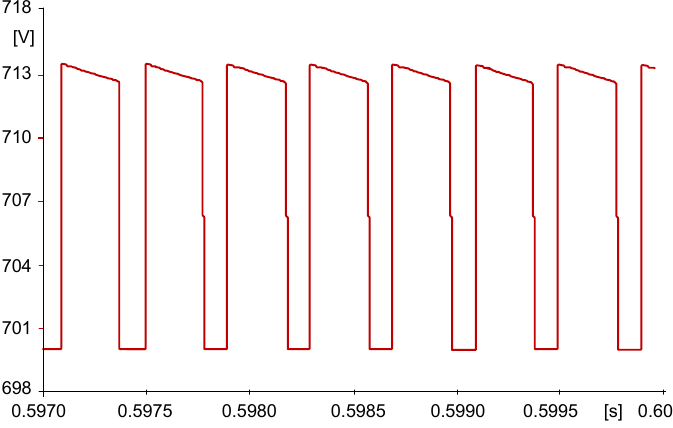
Figure 5. Variation of DC voltage for a cable with a length of 2 km, in proximity of the steady-state condition.